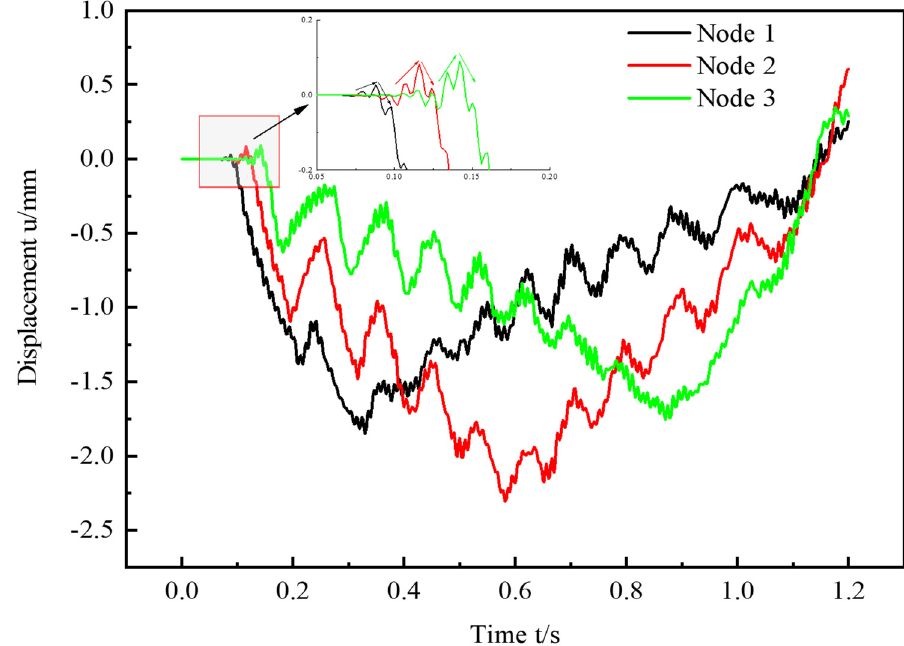
Figure 10. Node displacement time-history curve.